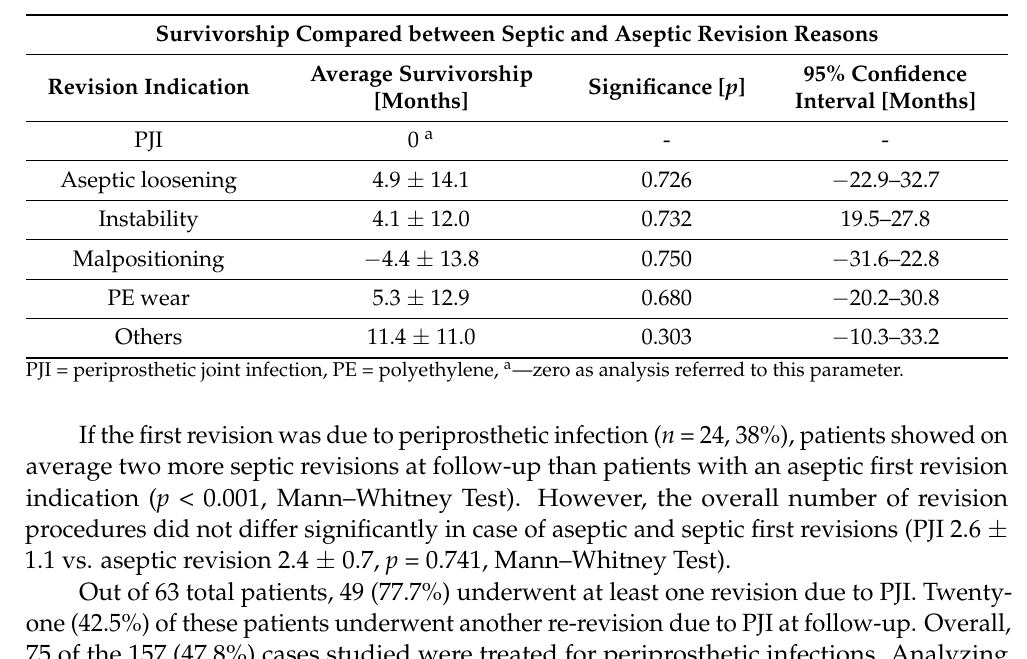
Table 2. Impact of the initial revision reason on average TKA survival (mixed model analysis).